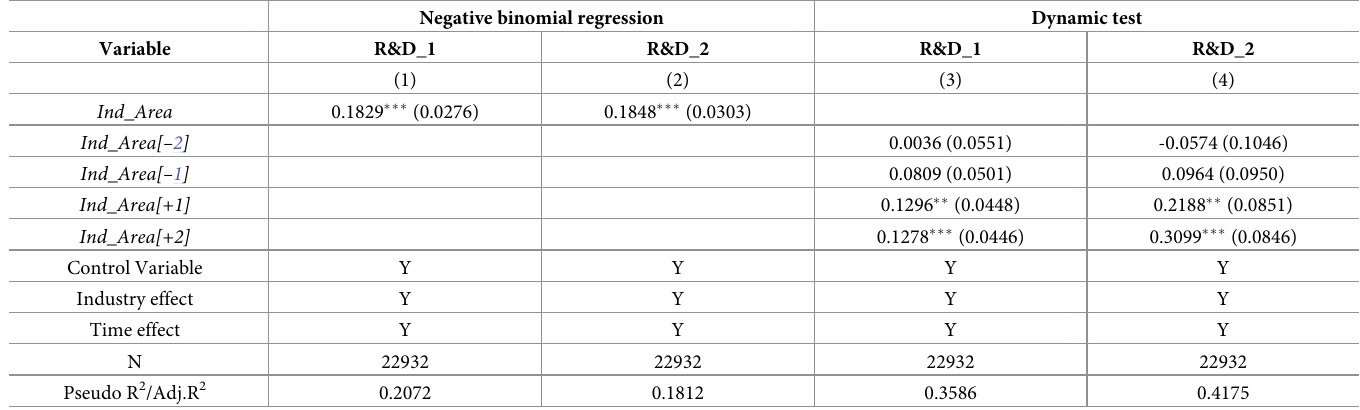
Table 12. Other robustness tests.